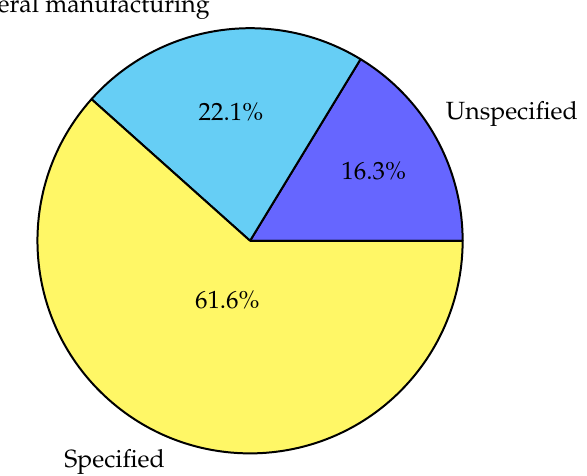
Figure 7. Distribution of papers by industry